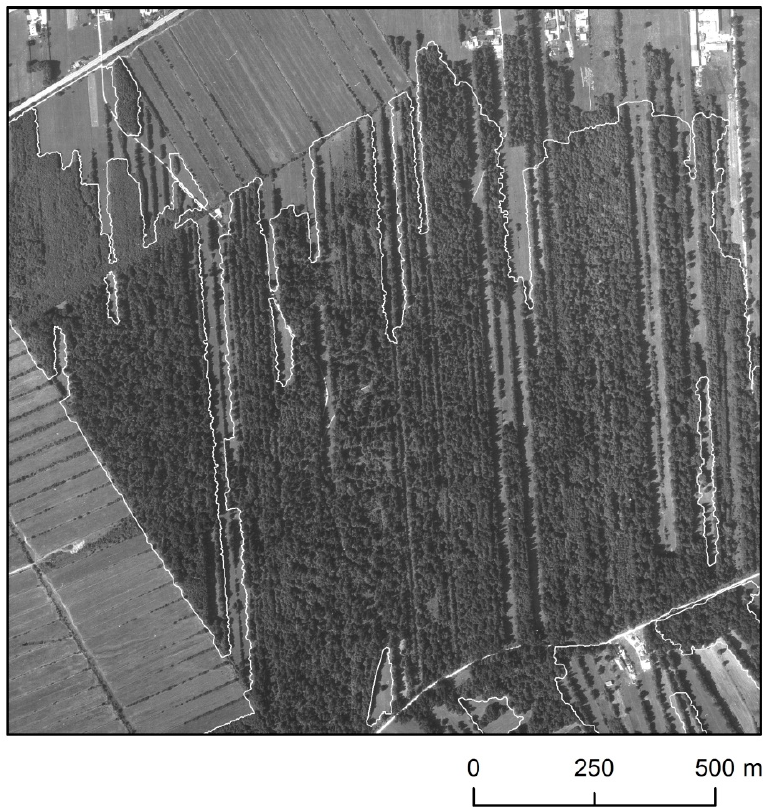
Figure 2. Orthophoto image showing forest patches, in the Barje area, in the year 1975, and the present forest edges (white line) determined based on the LiDAR data from the year